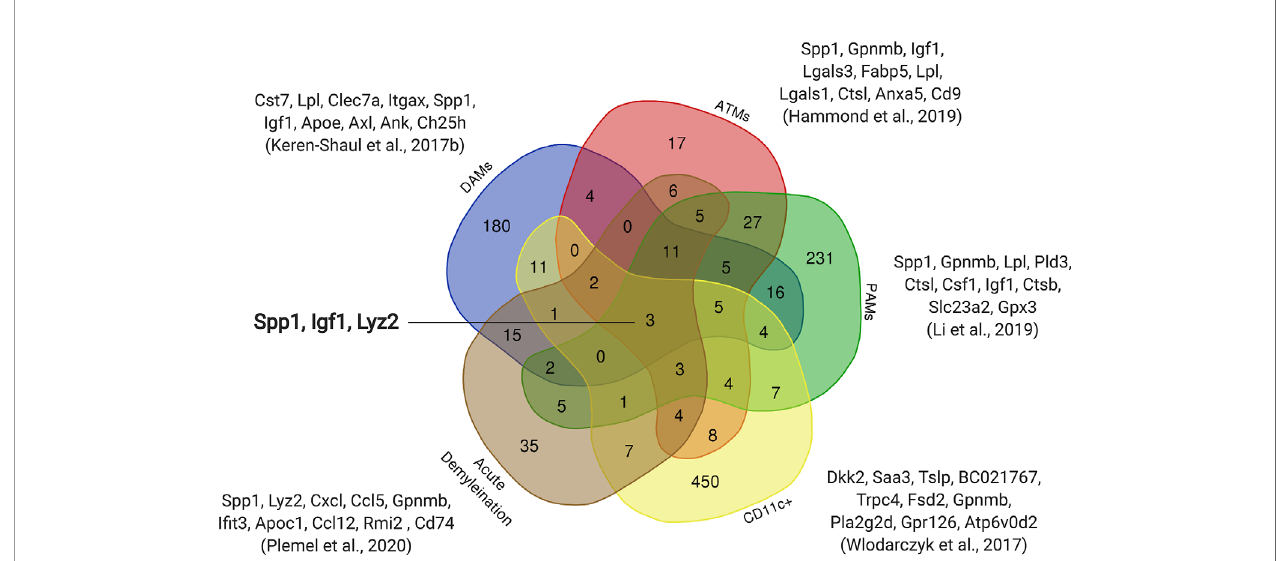
FIGURE 1 | Overlap of upregulated genes between early postnatal microglia and microglia in diseased models. Subsets of early postnatal microglia (ATMs, PAMs, Cd11c+) with similar transcriptomic pro fi les were observed in three independent studies (53, 54, 58). The transcriptomic pro fi le of an Alzheimer ’ s model (DAMs) (64) and an acute demyelination model (8) also show overlap with these postnatal microglia. The top ten upregulated genes from each dataset are shown with three genes that are common to all fi ve datasets ( Spp1, Igf1, Lyz2 ).